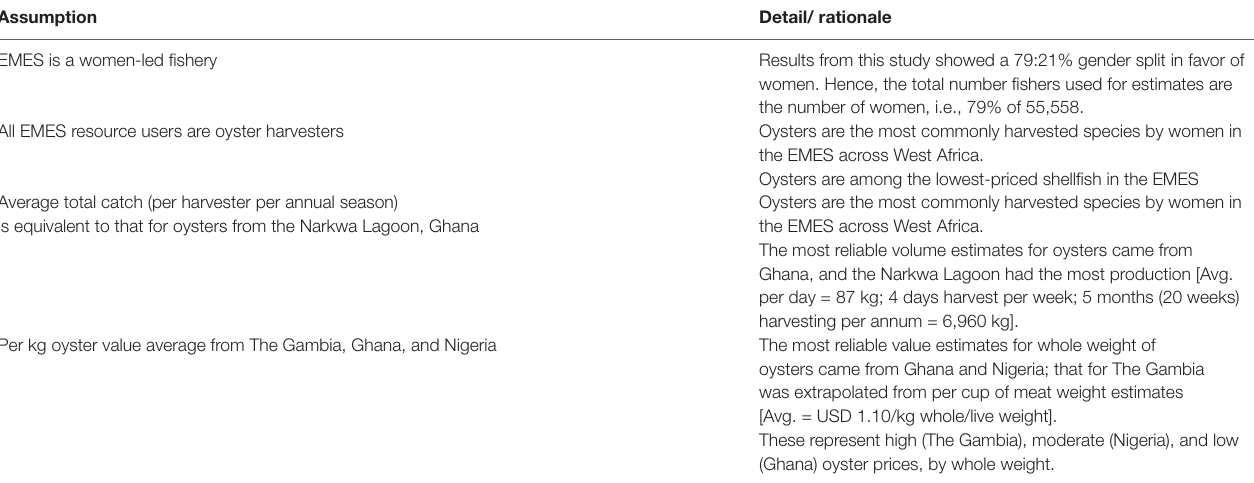
TABLE 3 | Details and rationale of assumptions used in the estimation of the volume and value of estuarine and mangrove ecosystem-based shellfisheries (EMES) in West Africa.